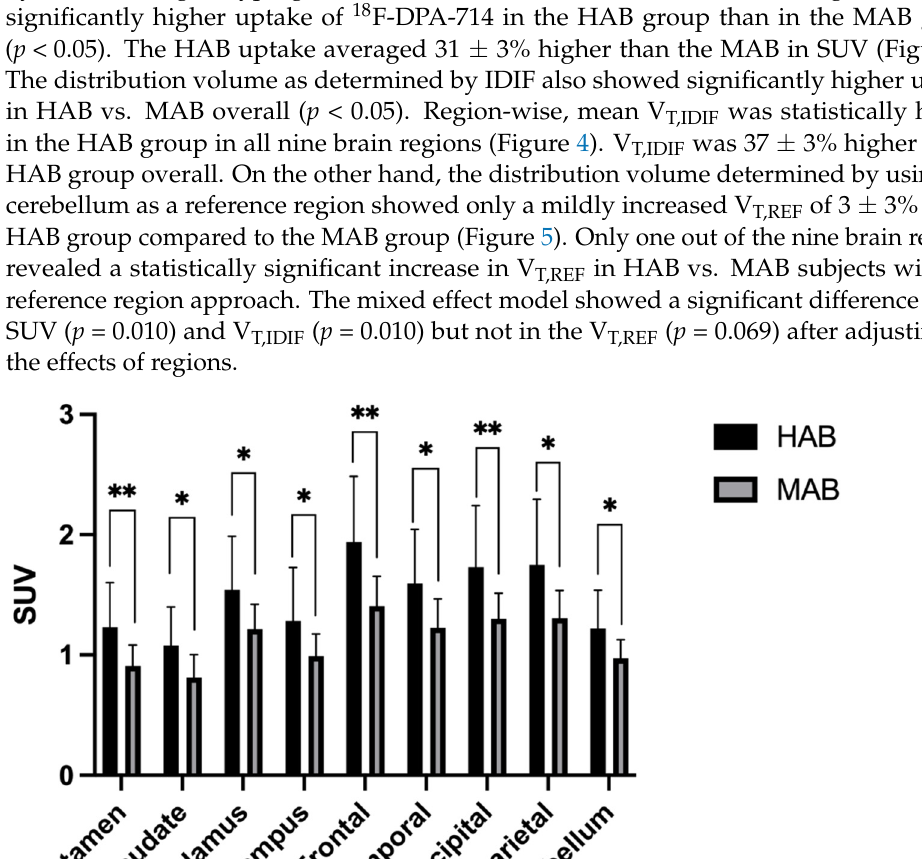
Figure 4. The box plot of the V T,IDIF . V T,IDIF is 37 ± 3% higher in HAB than in MAB. All nine regions were found with significant difference (*: p < 0.05, **: p < 0.01) between the HAB and MAB subjects. The overall increase pattern in the HAB is similar as the SUV pattern of increase.